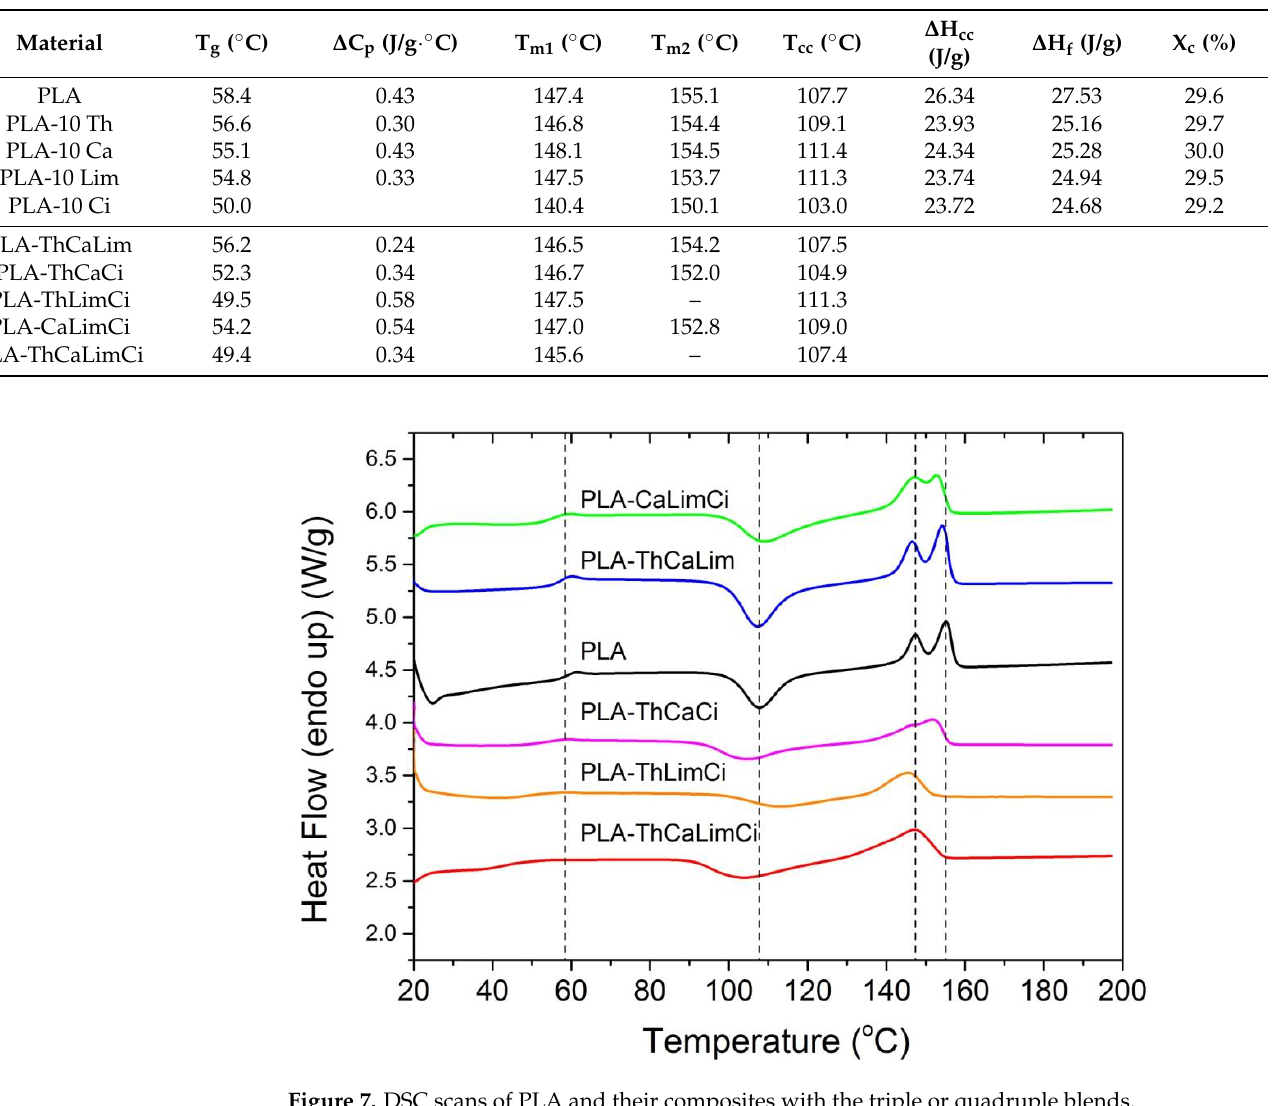
Figure 7. DSC scans of PLA and their composites with the triple or quadruple blends.